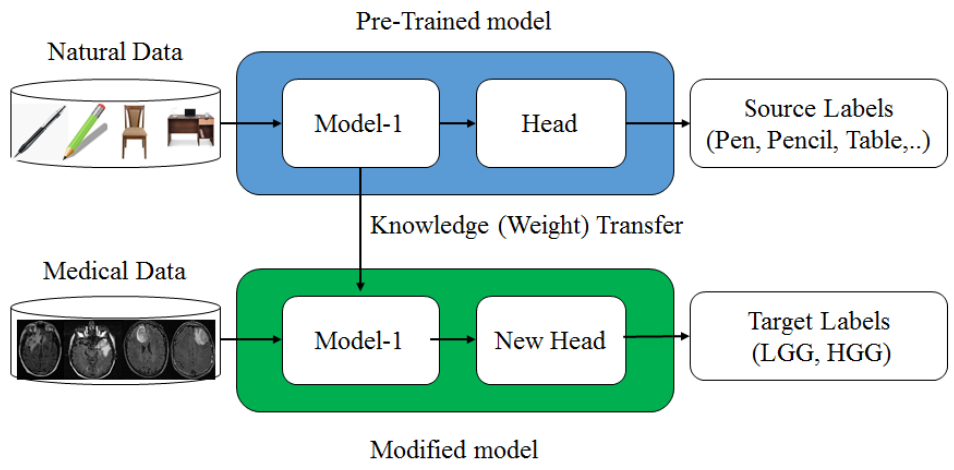
Figure 5. Transfer learning mechanism.